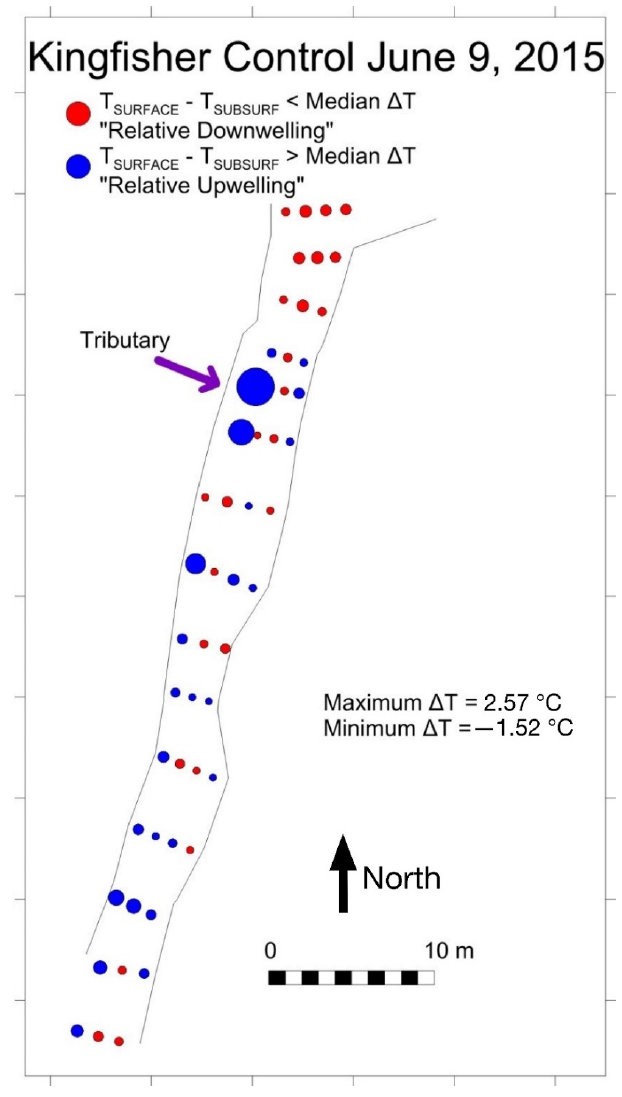
Figure 11. Map showing relative downwelling (red) and upwelling (blue) locations in the Kingfisher Control reach on 9 June 2015. The dots in the legend represent 1.0 ◦ C temperature di ff